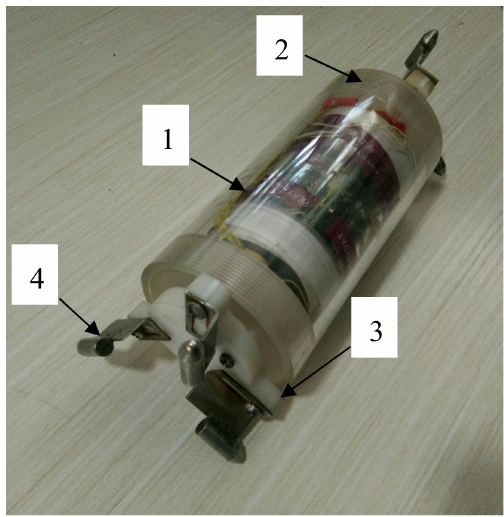
Figure 1. The structural sketch of piped carriage. Note: 1—Cylinder; 2—Plug; 3—Support body; 4—Support